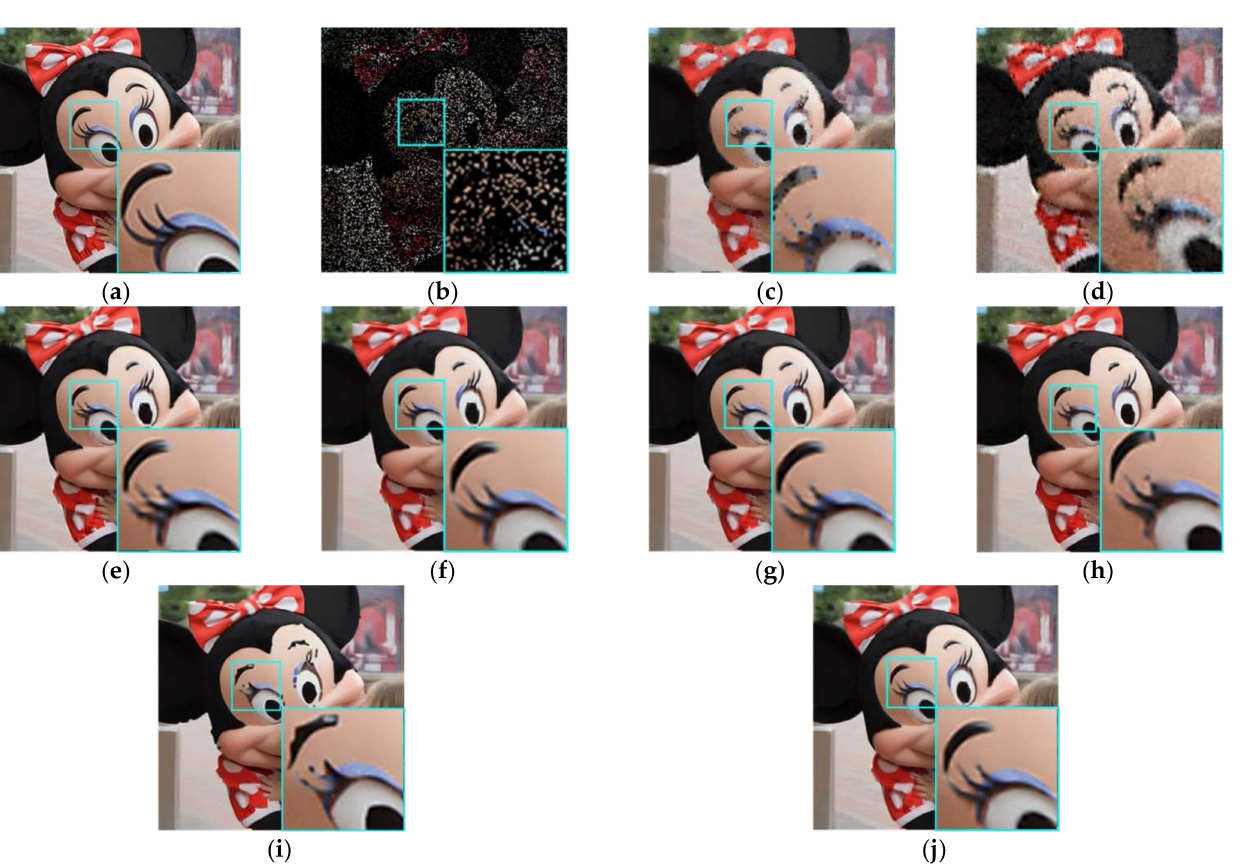
Figure 3. Results of Mickey image restoration with pixel missing rate of 80%. ( a ) Mickey; ( b ) Mickey with pixel loss rate 80%; ( c ) the result of SALSA [40] (PSNR = 24.26, SSIM = 0.8000); ( d ) the result of BPFA [41] (PSNR = 21.96, SSIM = 0.6512); ( e ) the result of GSR [3] (PSNR = 26.50, SSIM = 0.8816); ( f ) the result of JPG-SR [8] (PSNR = 26.75, SSIM = 0.8696); ( g ) the result of GSRC-NLP [9] (PSNR = 27.00, SSIM = 0.9197); ( h ) the result of IR-CNN [42] (PSNR = 24.87, SSIM = 0.8482); ( i ) the result of IDBP [43] (PSNR = 25.26, SSIM = 8422); ( j ) the result of our proposed HSR (PSNR = 28.25, SSIM =